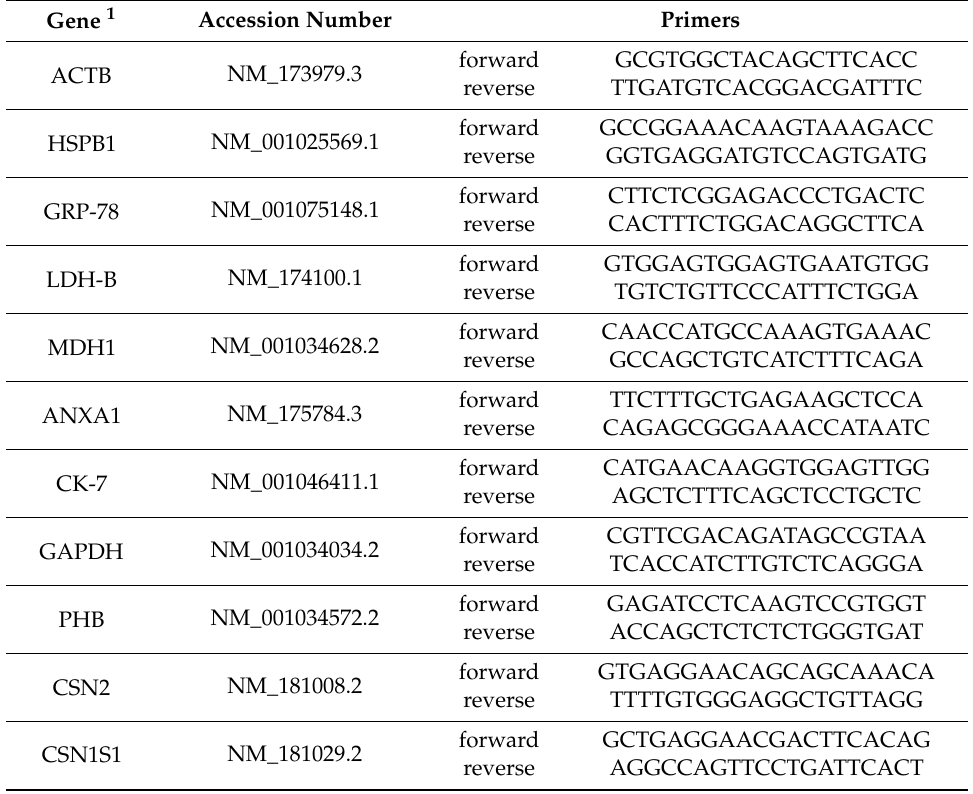
Table 1. Primer sequences for candidate genes used in this